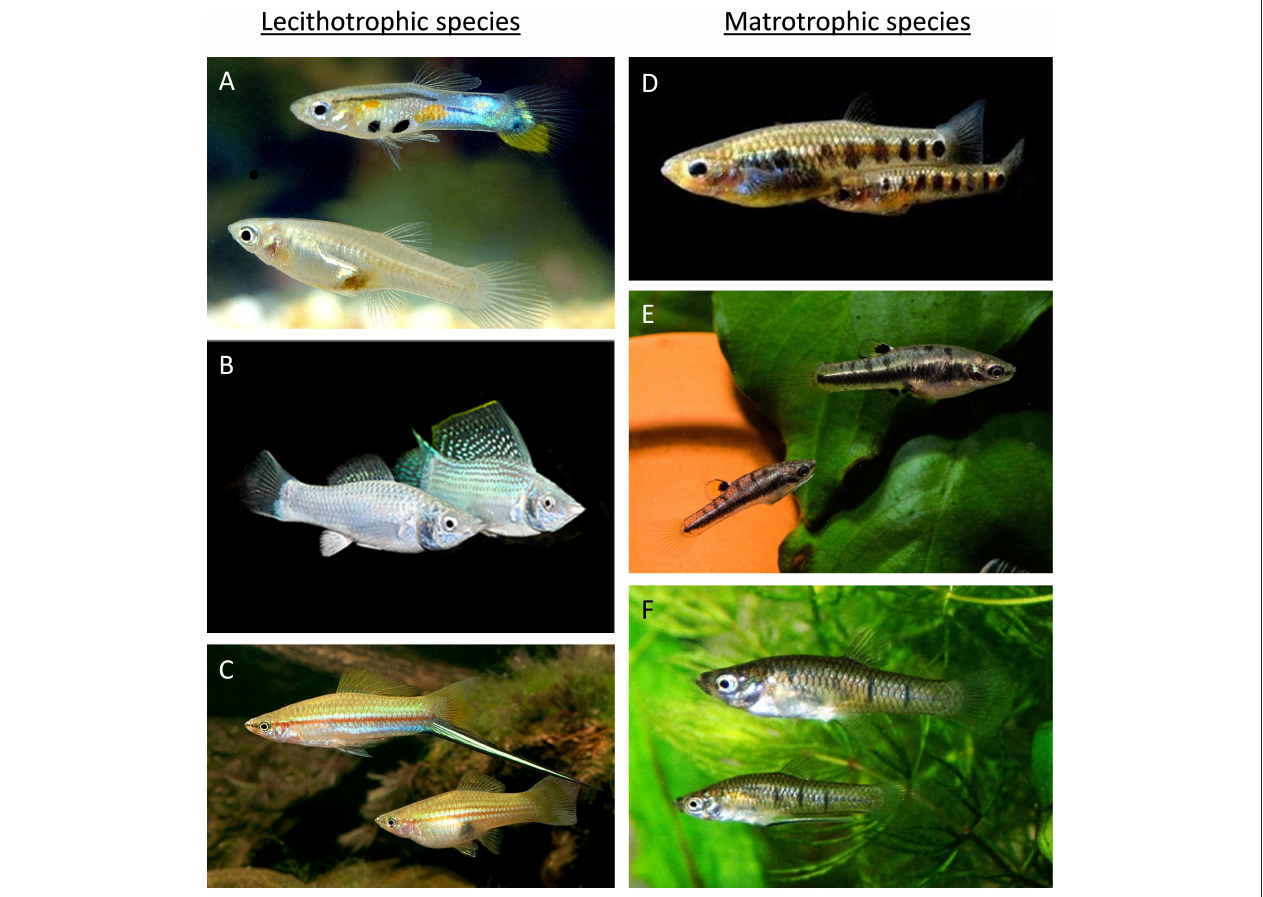
FIGURE 10 | Lecithotrophic species include many popular in aquariums such as the sexually dichromatic guppy, Poecilia reticulata (A) , the sailfin molly, Poecilia latipinna (B) , and the swordtail, Xiphophorus helleri (C) . Males of the latter two species also exhibit ornamental display traits in the form of a sail-like dorsal fin, and sword-like caudal fin. Males of all three species exhibit courtship and tend to have short gonopodia. In contrast, males of matrotrophic species such as (D) Poeciliopsis turneri , (E) Heterandria formosa , and (F) Phalloptychus juanarius tend to have sexually monochromatic coloration, lack ornamental display traits, and exhibit sneak-chase mating behavior rather than courtship. Furthermore, males in these species have long gonopodia and are considerably smaller than females. Photo credits: (A) Wikimedia Commons, (B) Johnny Jensen, JJPhoto.dk, (C) http://scontent-lhr3-1.xx.fbcdn.net, (D) aquafisher.org.ua, (E) Chiara Sciarone, (F)